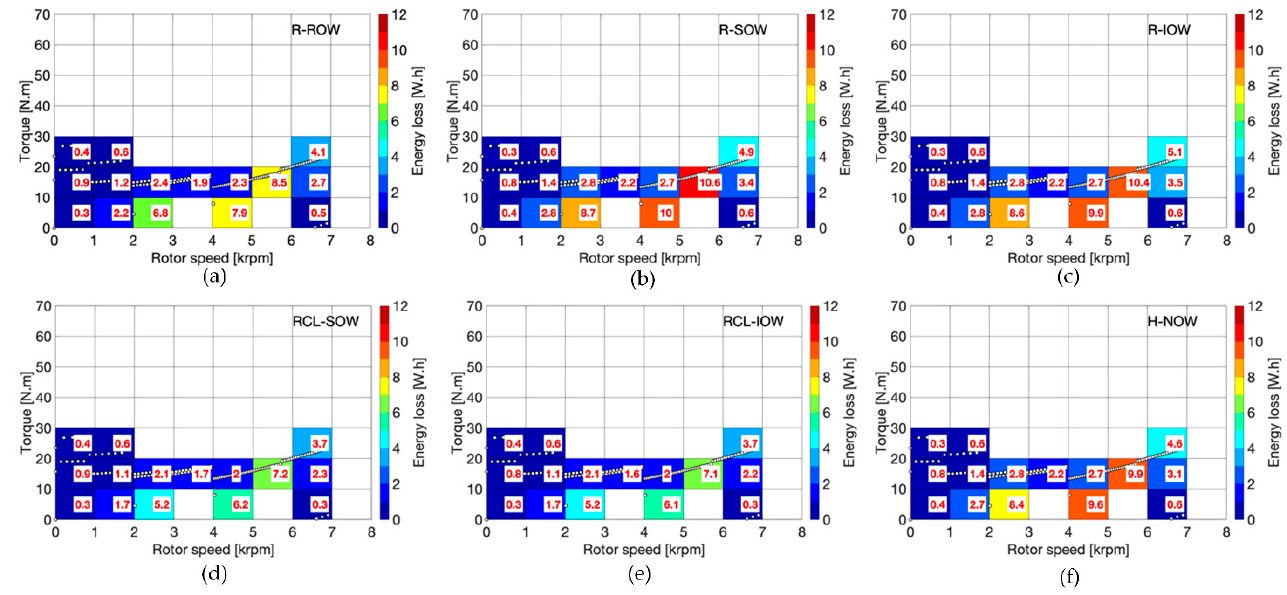
Figure 10. Energy loss distributions for the IPMSM with ( a ) R-ROW, ( b ) R-SOW, ( c ) R-IOW, ( d ) RCL-SOW, ( e ) RCL-IOW, and ( f ) H-NOW arrangements, along the NEDC driving cycle.